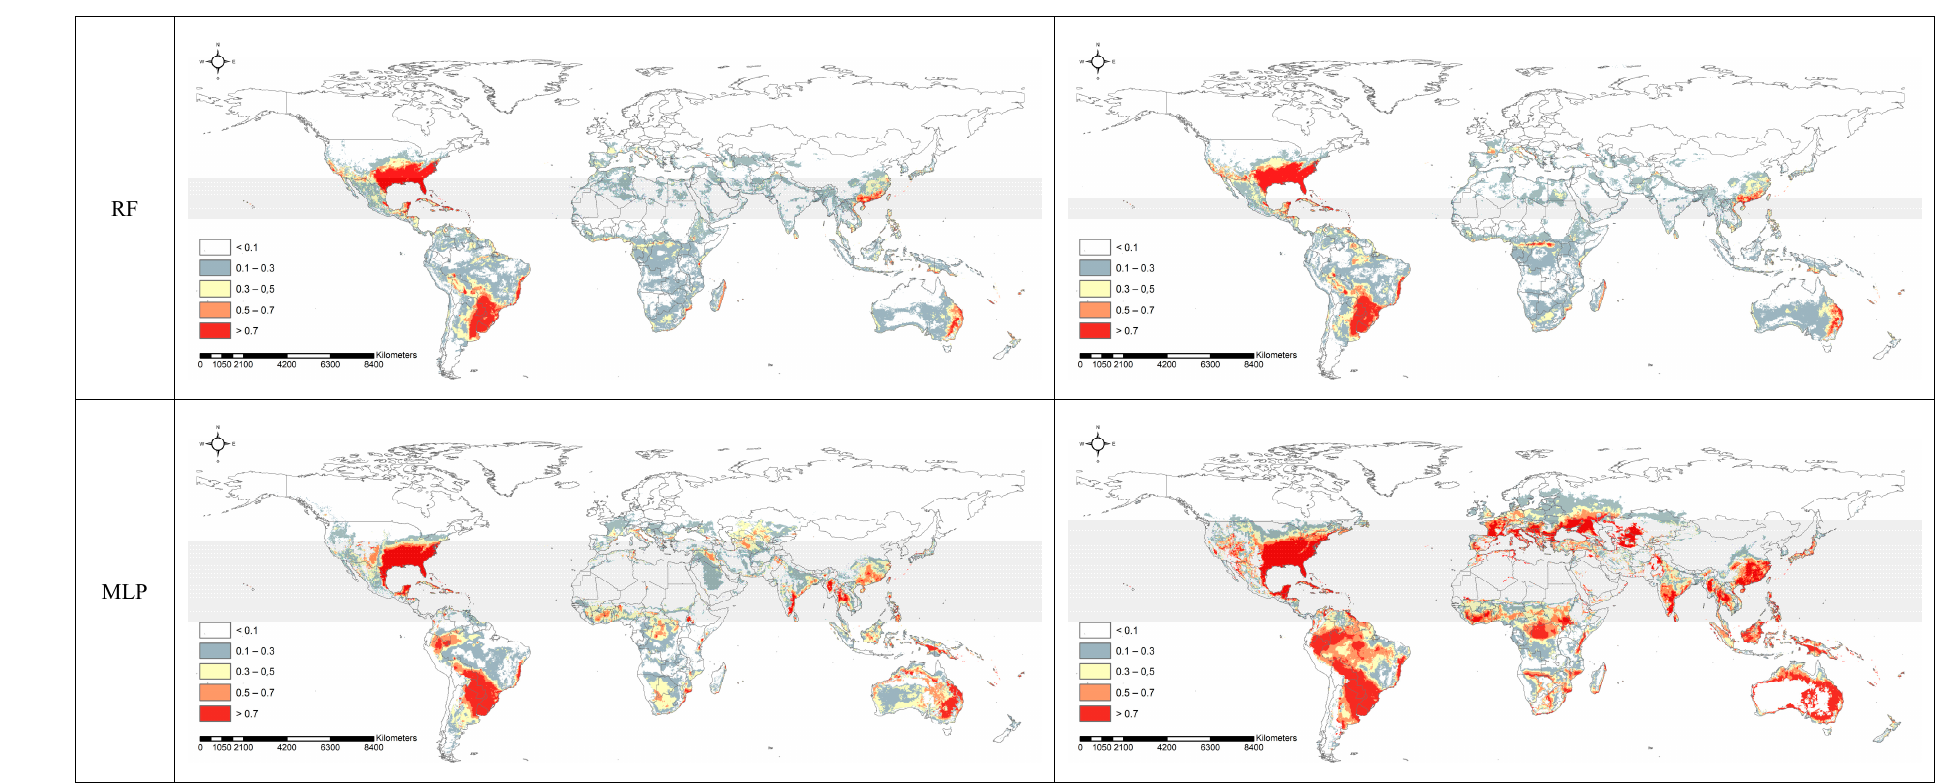
Figure 4. Potential distribution of S. invicta by regressing occurrence possibility evaluated by each model and climate change scenario.